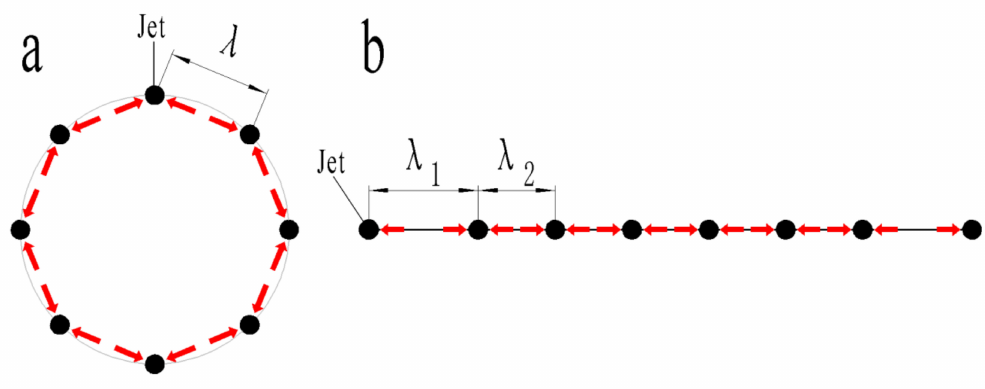
Figure 12. Diagram of interaction forces between jets: ( a ) annular closed curve; ( b ) straight-line open curve.